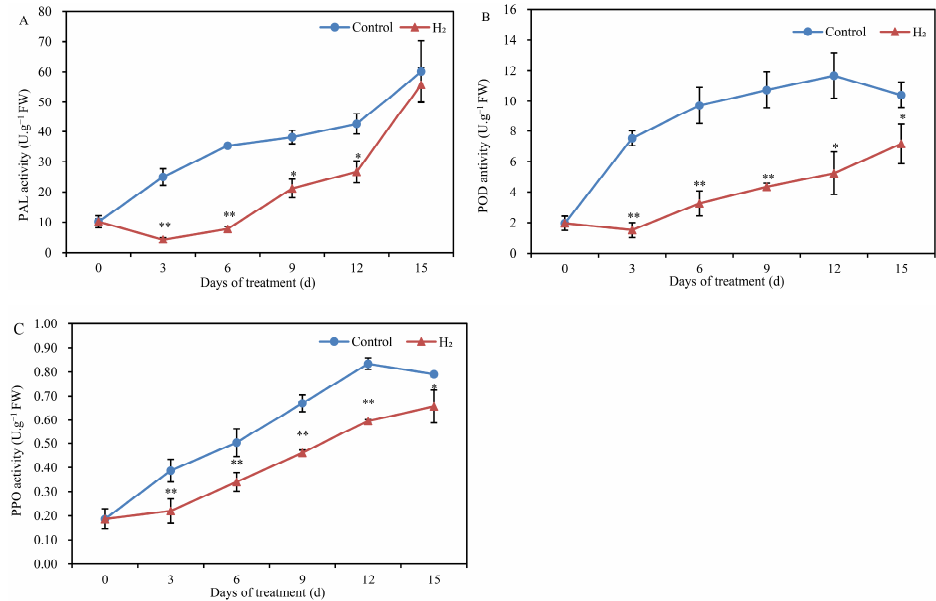
Figure 2. Changes in enzyme activities in Lanzhou lily scales with or without H2 fumigation during storage at room temperature for 15 days. ( A ) PAL, phenylalanine ammonia-lyase; ( B ) POD, peroxidase; ( C ) PPO, polyphenol oxidase. The error bars indicate the means ± SE (n = 9 scales from each of three independent experiments). Values with asterisks are significantly different (* p < 0.05; ** p < 0.01) from the control treatment on the same day according to independent t - test. d: days.